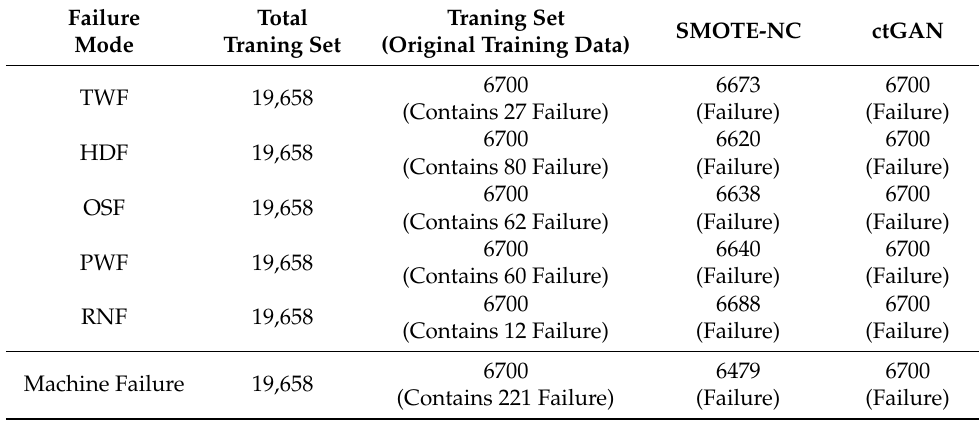
Table 4. The number of samples generated by SMOTE-NC and ctGAN.